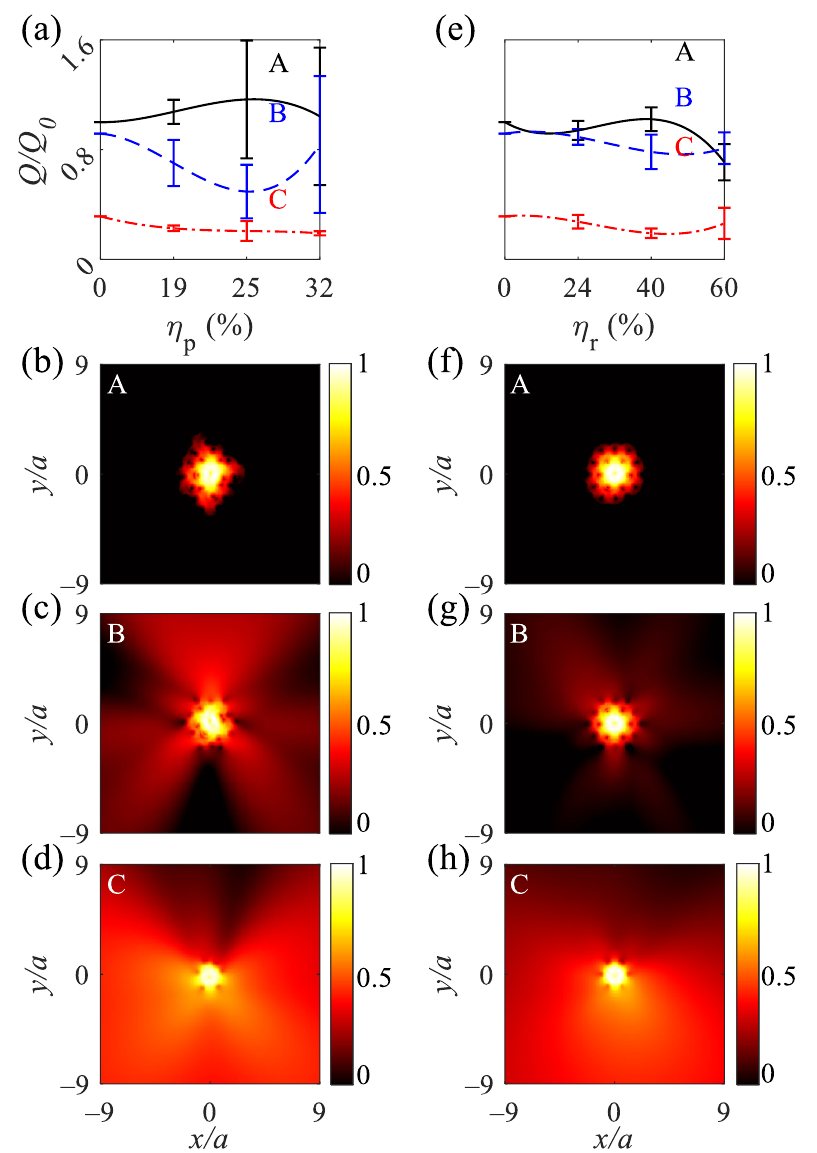
Figure 9. Normalized quality factor for A-, B-, and C-type cavities under ( a ) η p = 19, 25, and 32% and ( e ) η r = 24, 40, and 60%. ( b – d ) Normalized logarithmic electromagnetic power distributions for the A, B, and C-type cavities at λ = 428,400, and 400 nm, respectively. ( f – h ) Normalized logarithmic electromagnetic power distributions for the A, B, and C-type cavities at λ = 424,410, and 410 nm,